Question: Is the quantity shown trending increasing or decreasing?
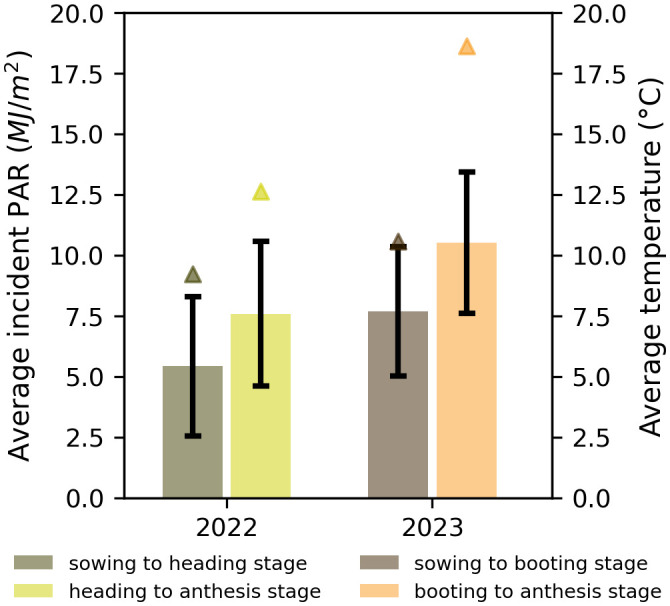
Answer: increasing